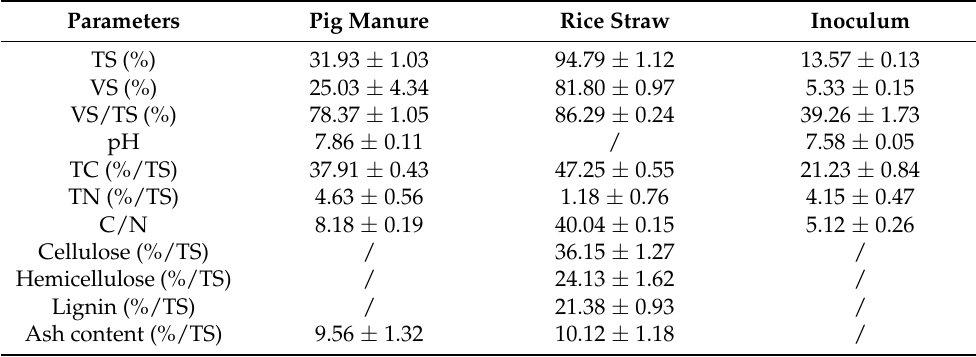
Table 1. The characteristics of pig manure, rice straw, and inoculum.